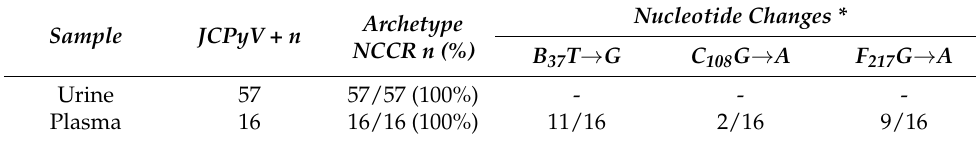
Table 8. Sequence analysis of JCPyV NCCR.